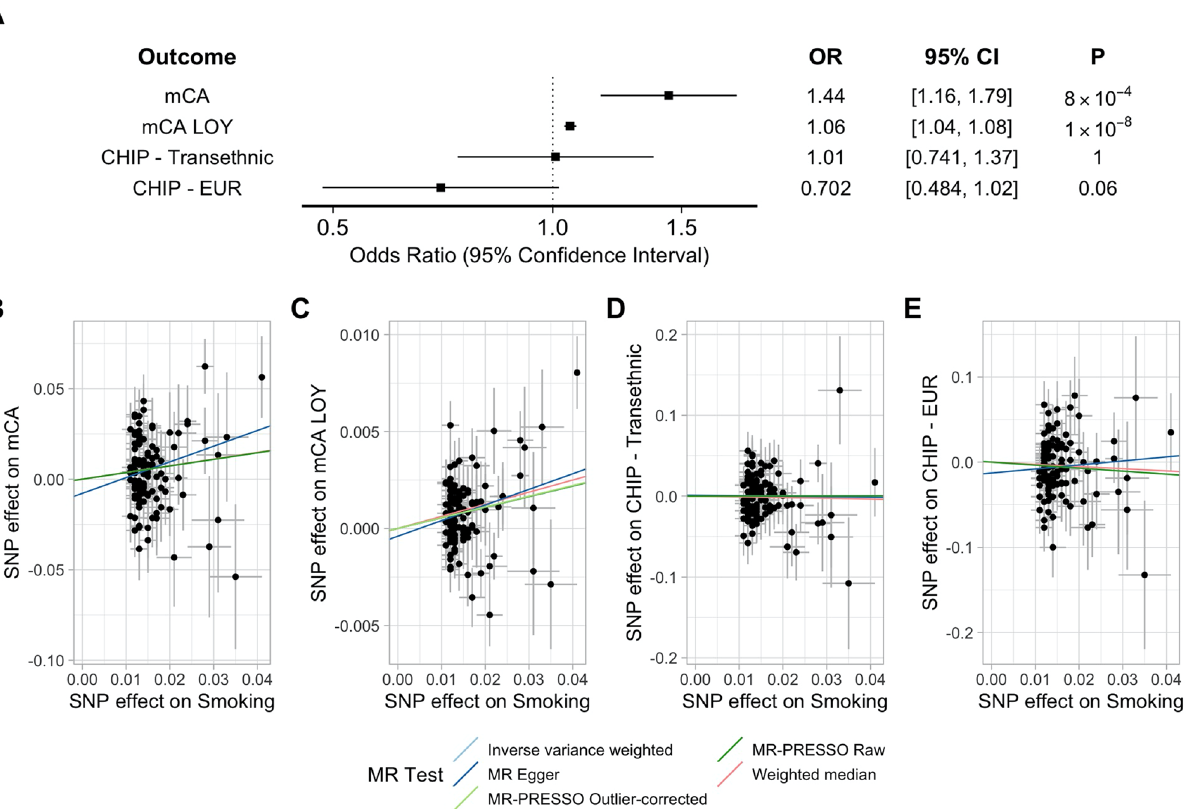
Figure 2. Mendelian Randomization associations between smoking and somatic mutations. Results of MR testing the associations between smoking and mCA and CHIP outcomes. ( A ) Inverse-variance weighted MR results. ( B – E ) MR results testing the association between smoking and each outcome using alternative MR methods. EUR =